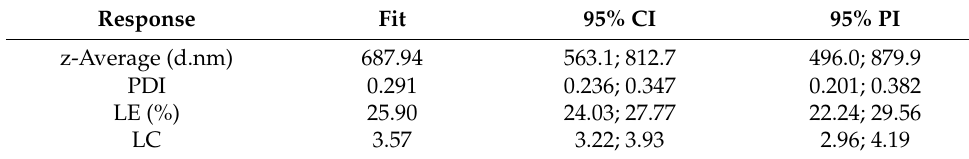
Table 7. Prognosis for optimised parameters of response surface.